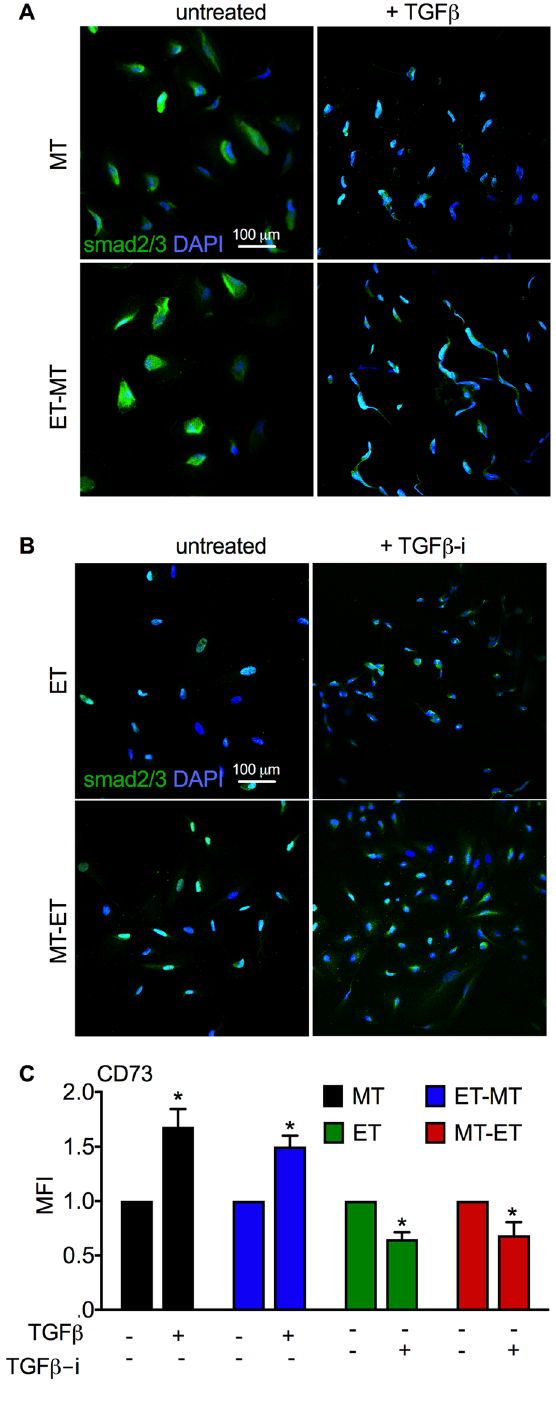
Figure 5. TGF β signaling in RS-hAFSCs cultured in different conditions. Confocal immunofluorescence staining for SMAD2/3. Nuclei were stained with DAPI (blue). ( A ) RS-hAFSC cells were cultured in MT or ET-MT with and without (untreated) supplementation with TGF β . ( B ) RS-hAFSC cells were cultured in ET or MT-ET with and without (untreated) supplementation with a TGF β inhibitor (TGF β -i). ( C ) Mean fluorescence intensity (MFI) for the different groups (measured from 10,000 cells and using the same CD73 antibody concentration, experimental conditions and cytometer settings for all groups). Data represent mean ± SEM. SEM: standard error of the mean. ** P <